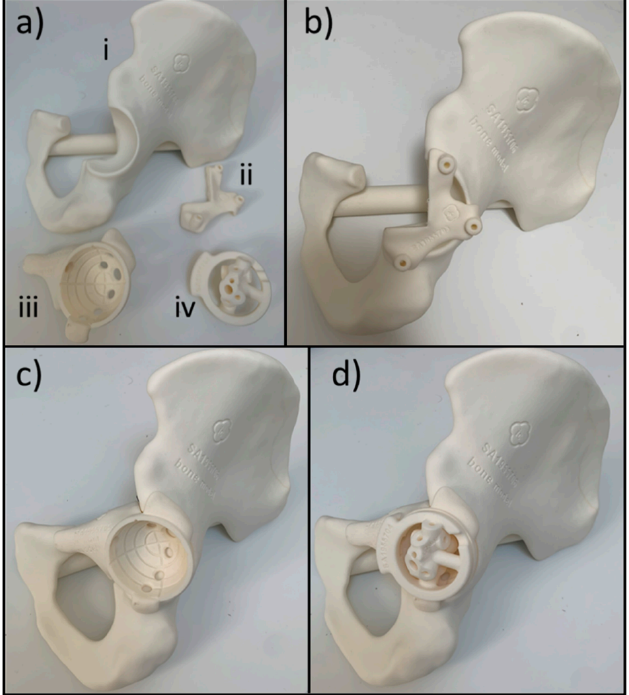
Figure 6. Images demonstrate the 3D printed components used for the accurate resection of a pelvic tumour. ( a ) shows 3D printed components involved—( i ) is a 3D printed model of the patient’s pelvis post-osteotomies, ( ii ) is the guide for the posterior and inferior cuts, ( iii ) is a template of the 3D printed implant, ( iv ) is the drill bit guide jig. The superior pubic ramus was cut under computer assisted navigation surgery (CANS) guidance, before the posterior and inferior cut saw guide was positioned as shown in ( b ) and held in place with pins. After the cuts were made, the template was positioned in the patient as shown in ( c ). The drill bit guide was the positioned as shown in ( d ) which, in conjunction with the implant template, ensured the screw holes are drilled correctly for the custom implant. Implants from Implantcast